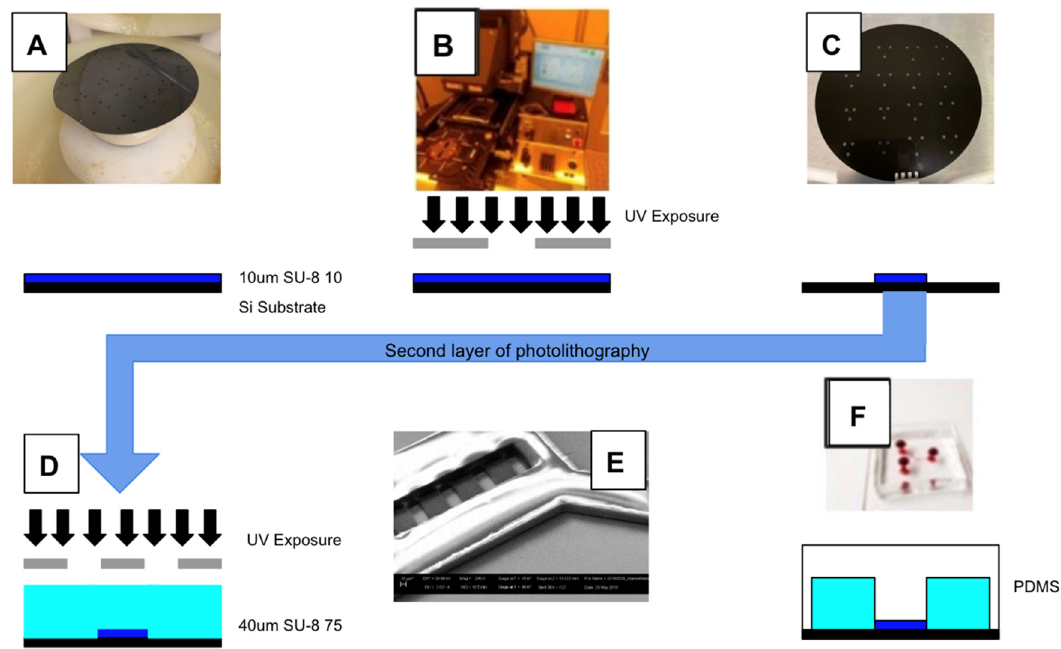
Figure 3. The µ OS is manufactured using a two-step photolithography process with elastomeric micromolding. ( A ) The first layer of negative photoresist is spin-coated onto a silicon wafer at a height of 10 µ m. ( B ) The photoresist-treated wafer is irradiated with ultraviolet light at using a mask aligner with a designed photomask. ( C ) The patterned wafer is developed and washed. ( D ) A second layer of photoresist is then applied onto the patterned wafer by repeating processes ( A – C ) to create a height of 50 µ m for greater stability. ( E ) SEM image of a photoresist-patterned silicon wafer used for micromolding the µ OS design in PDMS. ( F ) The silicon wafer undergoes silanization, enabling a mixture of polydimethylsiloxane (PDMS) to coat the wafer surface and undergo curing to create an elastomer with the desired pattern. This elastomer is peeled away from the wafer surface, cut to size, and plasma bonded onto a chemically cleaned glass slide or coverslip.